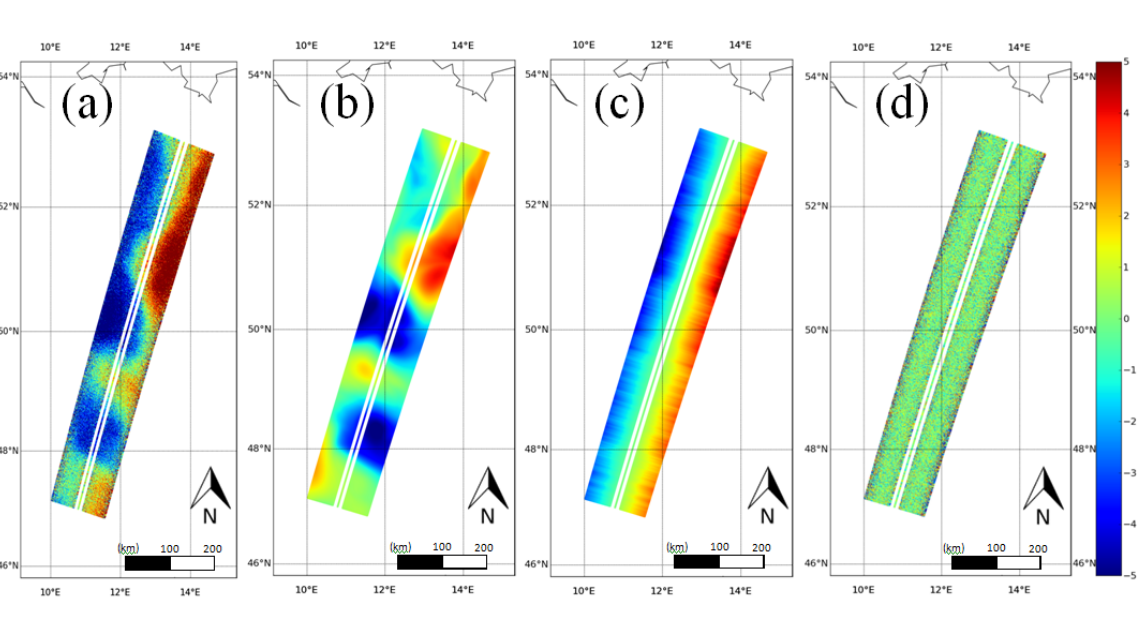
Figure 3. Decomposition of a simulated KaRIN topography image ( a ) as the sum of the “true” topography derived from a high-resolution ocean model from Klein et al. [8] ( b ), the roll error ( c ) derived from the roll sample from Figure 2b, and instrumental white noise ( d ). Unit: